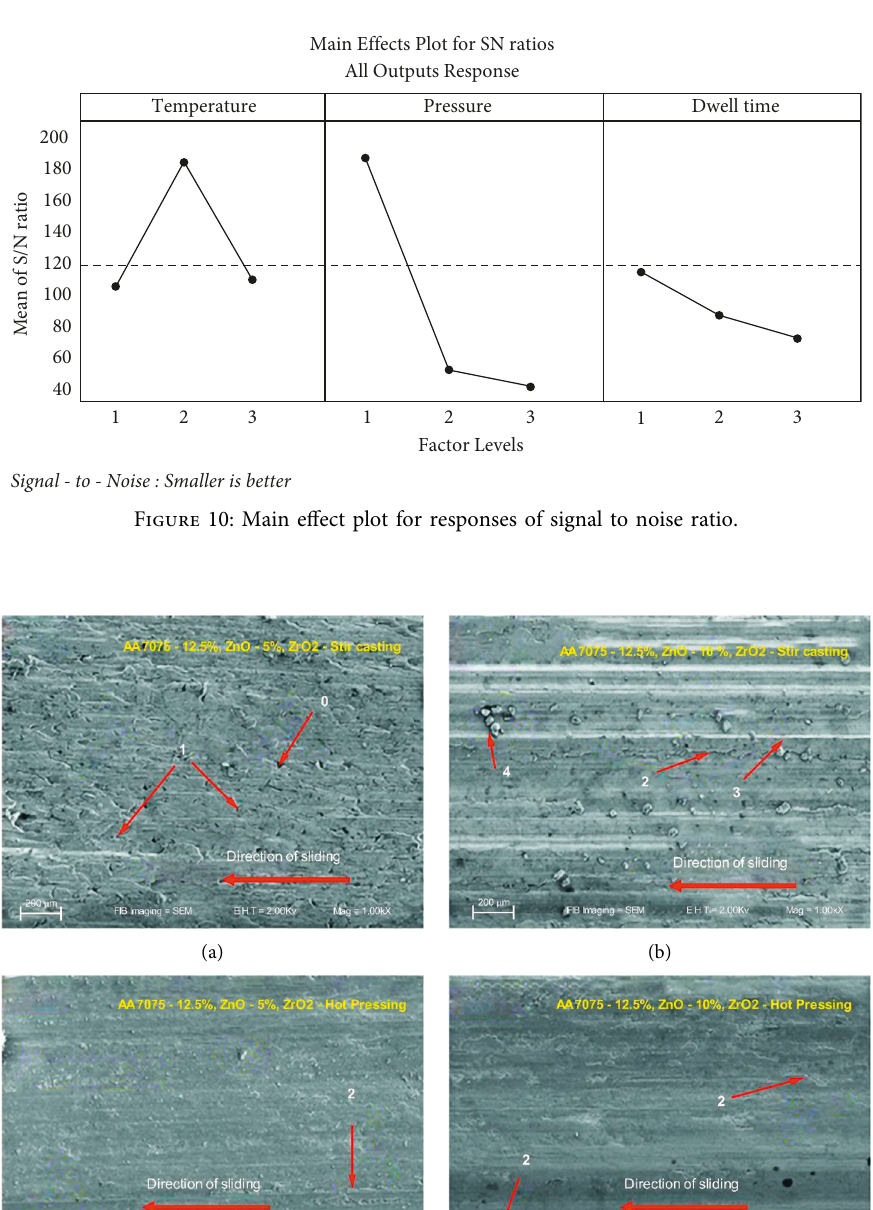
2 composites. (a) AA7075-12.5%, ZnO-5%, ZrO 2 -